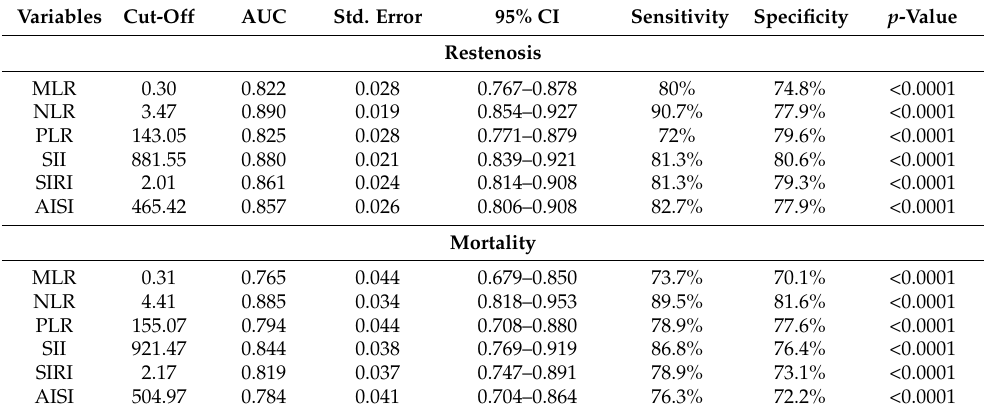
Table 2. The AUC of the ROC curve, 95% confidence interval, sensitivity, and specificity of the preoperative inflammatory markers.